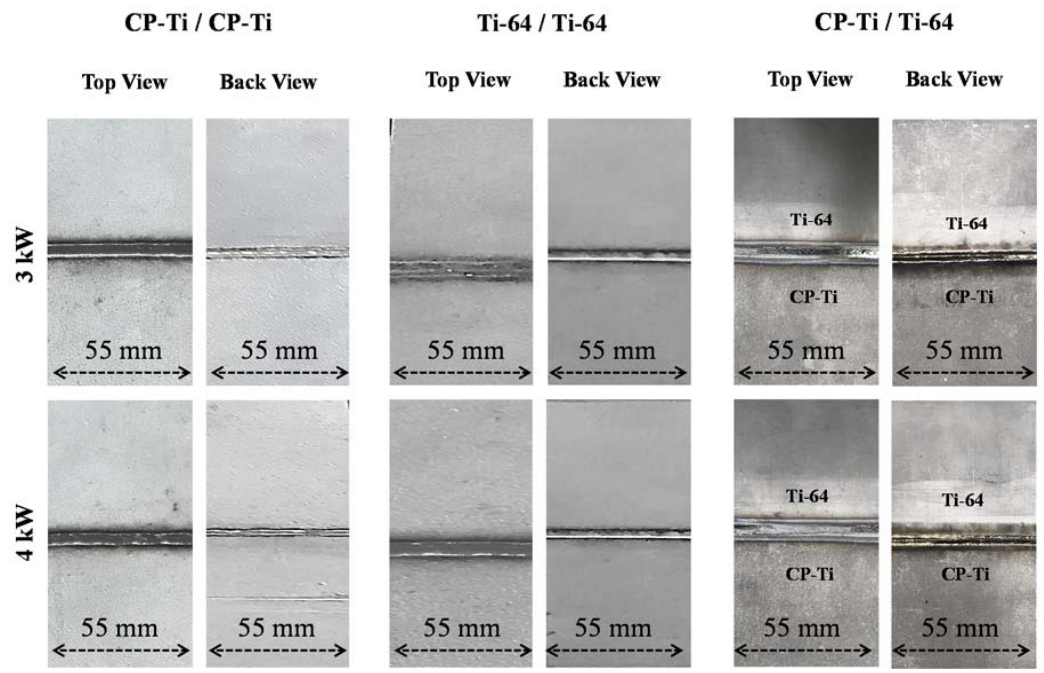
Figure 1. Macrostructures for all the joints.